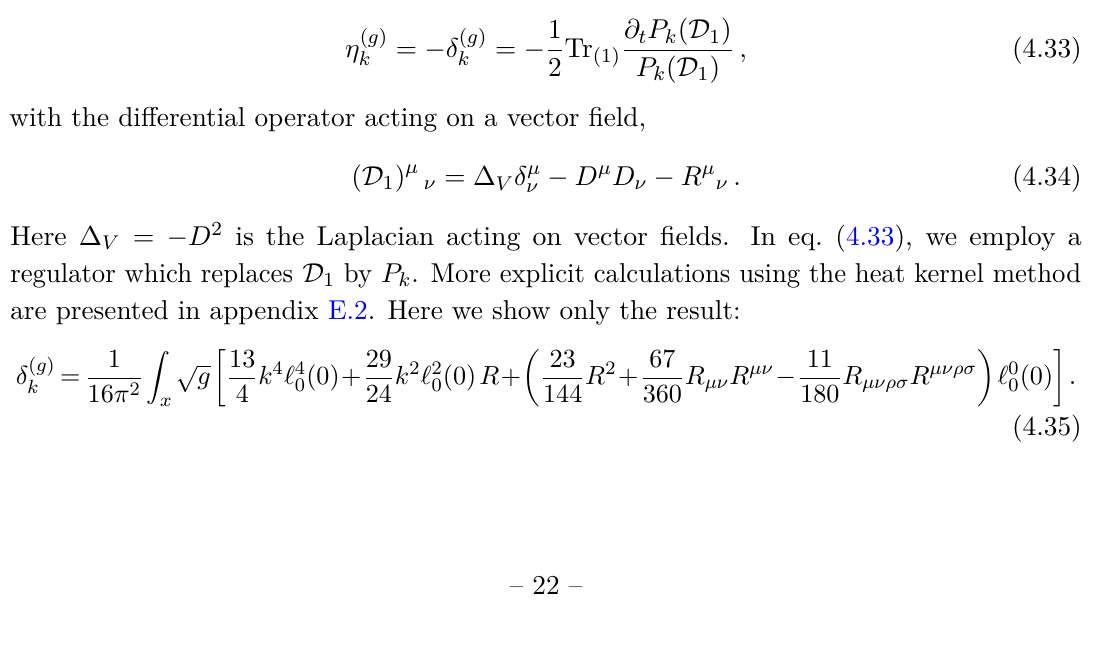
and the ghost ones (cid:15) ( g ) k